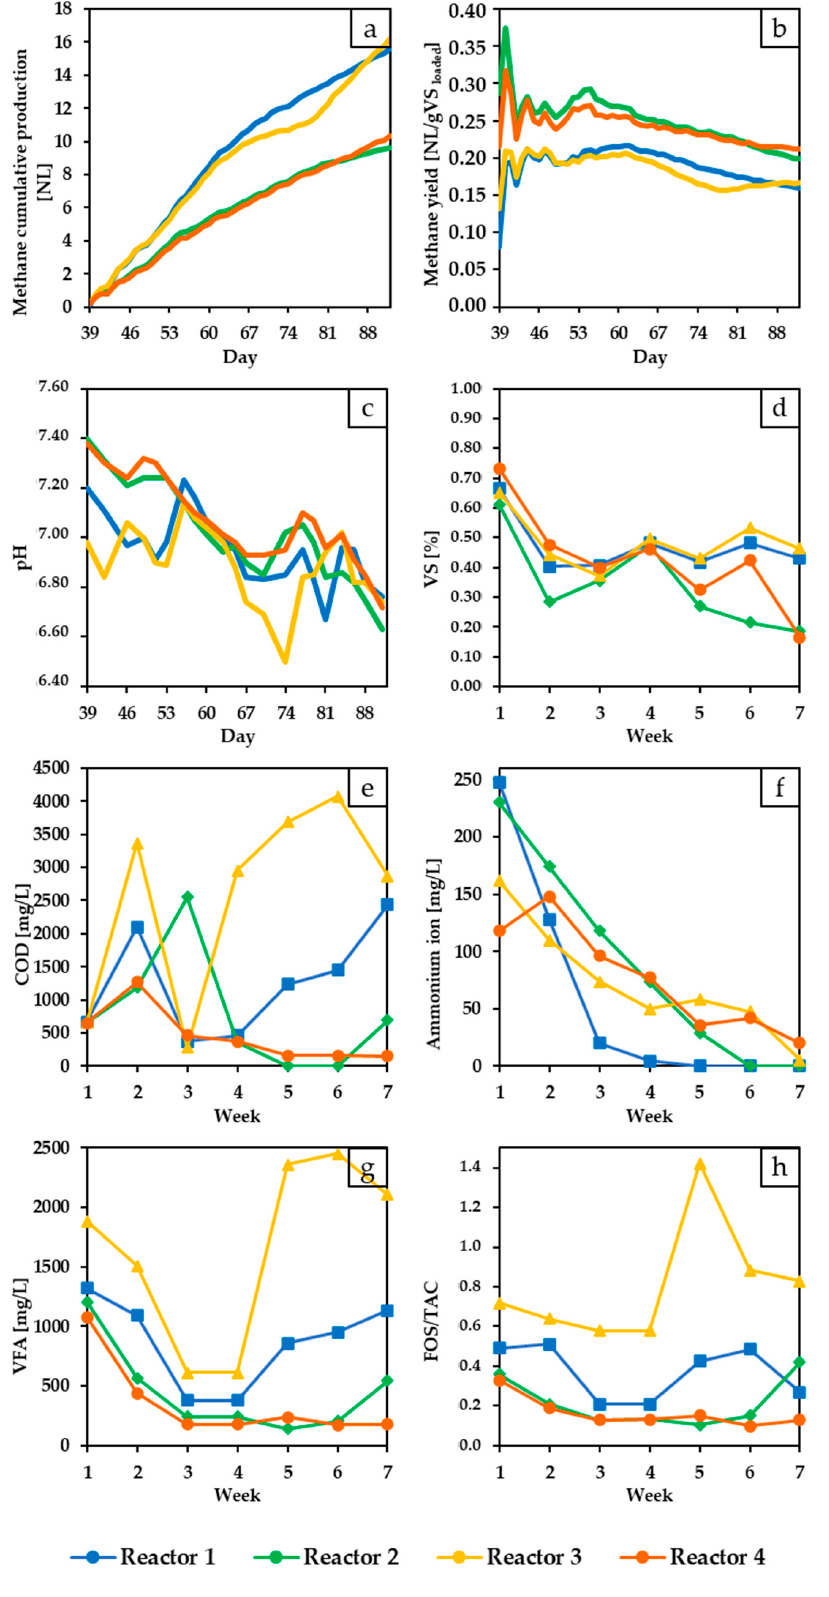
Figure 3. Semi-continuous experiments results: ( a ) methane cumulative production, ( b ) methane yield, ( c ) pH, ( d ) volatile solids, ( e ) COD, ( f ) ammonium ion, ( g ) VFA, and ( h ) FOS/TAC.